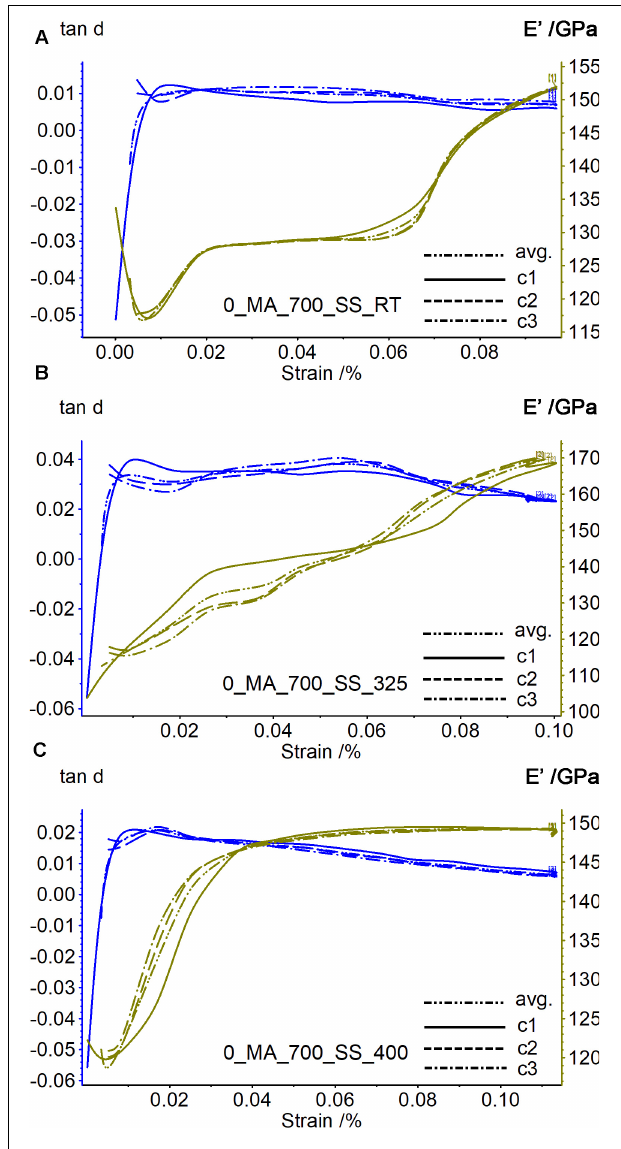
FIGURE 12 | Influence of test temperature on the dynamic behavior of 0_MA_700 specimens, during DMA SS, at: (A) T 1 = RT; (B) T 2 = 325 ◦ C and (C) T 3 = 400 ◦ C (reproduced after Pricop et al., 2018, with permission granted by Taylor & Francis).